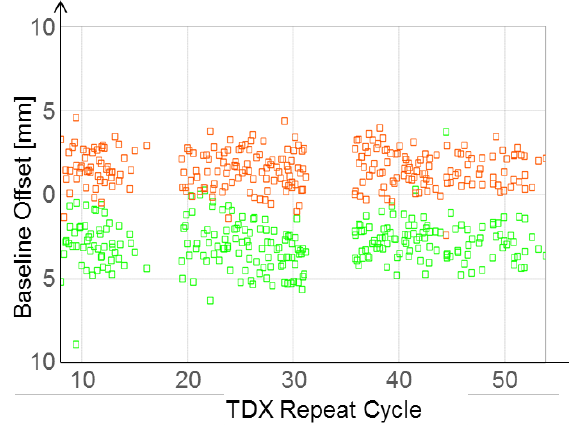
Figure 3: Baseline calibration results over time. Red: radial component, green: cross track component.